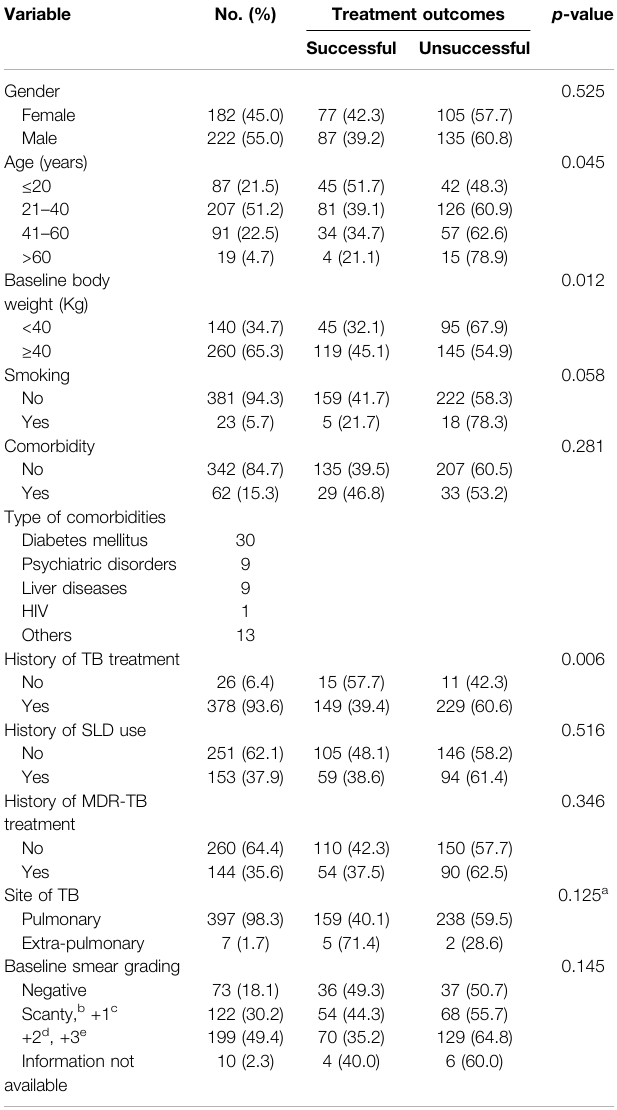
TABLE 1 | Patients ’ socio-demographic, clinical and microbiological characteristics and treatment outcomes. Variable